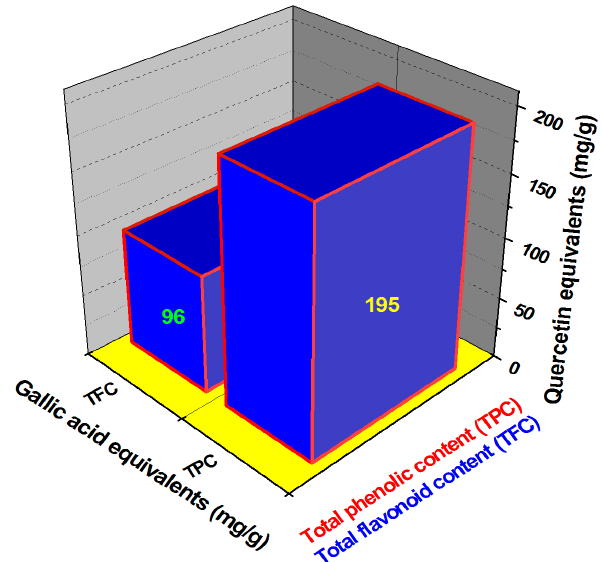
Figure 2. Total phenolic and flavonoid content of T. aralioides .